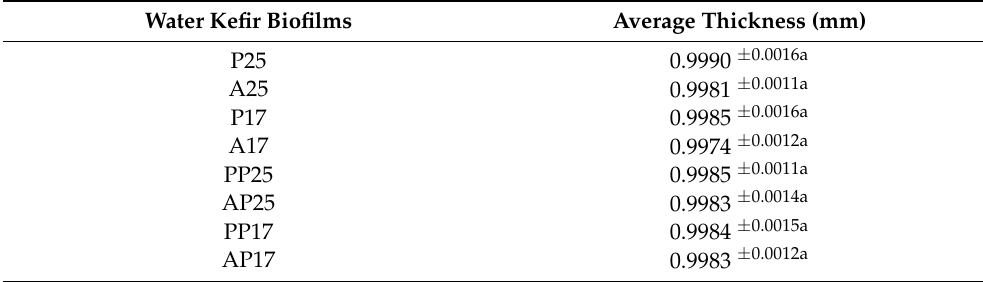
Table 7. Thickness of water kefir grains